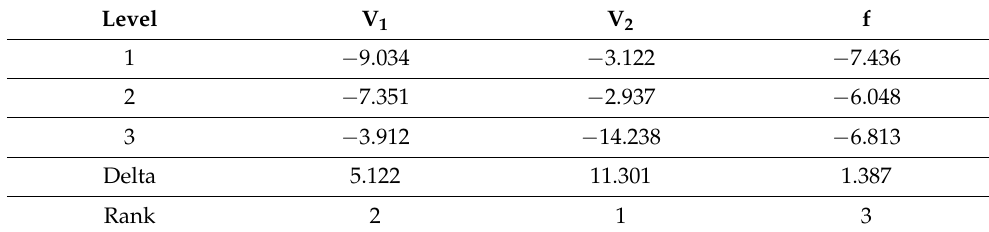
Table 7. Responses for signal-to-noise ratios (larger is